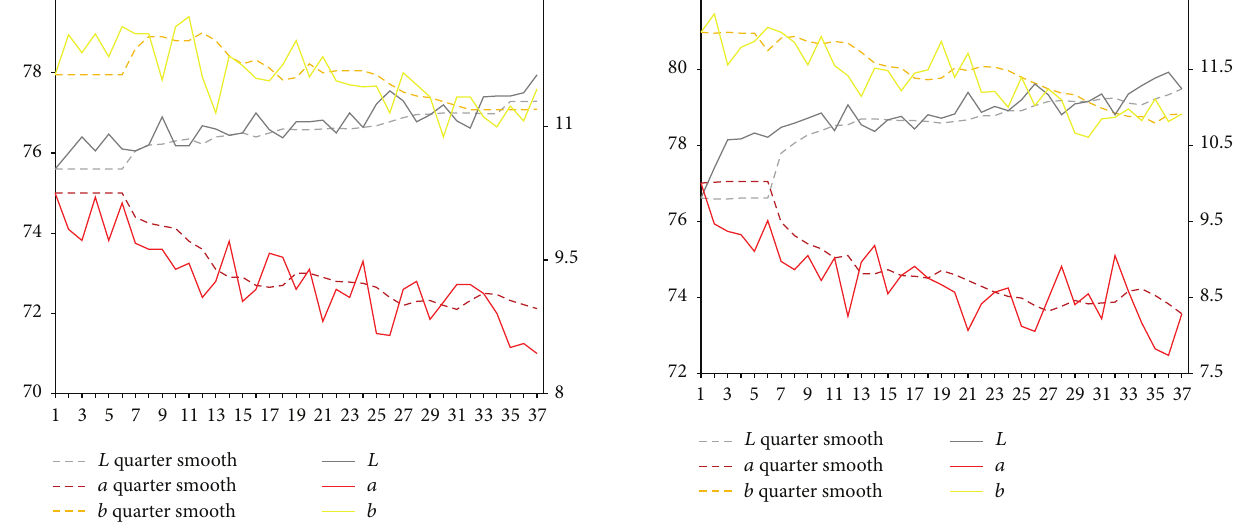
Figure 7: Lab value changing trend of nose.